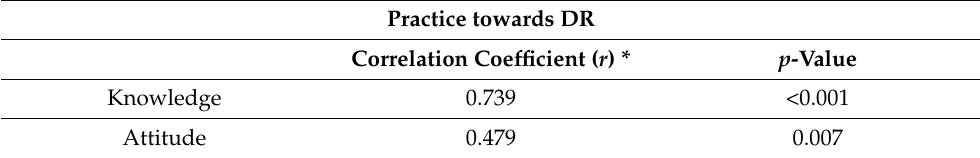
Table 4. Correlation between the knowledge, attitude, and practice towards DR.